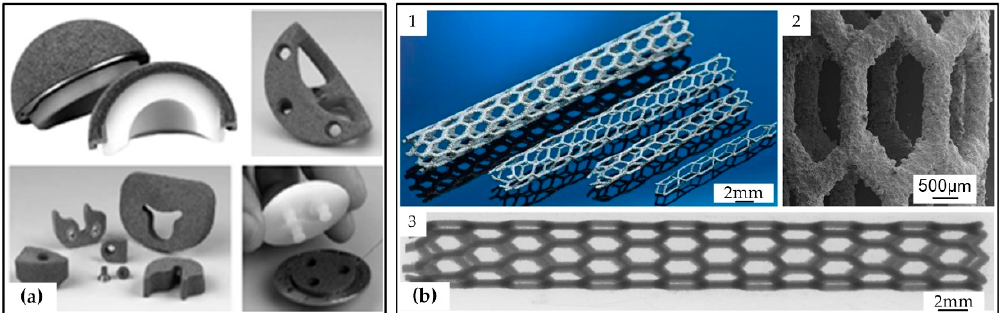
Figure 3. Some metallic orthopedic implants: ( a ) porous tantalum implant, top row: acetabulum implant. Bottom row: total knee arthroplasty (TKA) implants, and patella implant, reproduced from [54], with copyright permission from Elsevier, 2006; ( b ) zinc metal heart stent, reproduced from [77], with copyright permission from Elsevier, 2018; 1. The samples, 2. The scanning electron microscope (SEM) picture, 3. The X-ray graph.